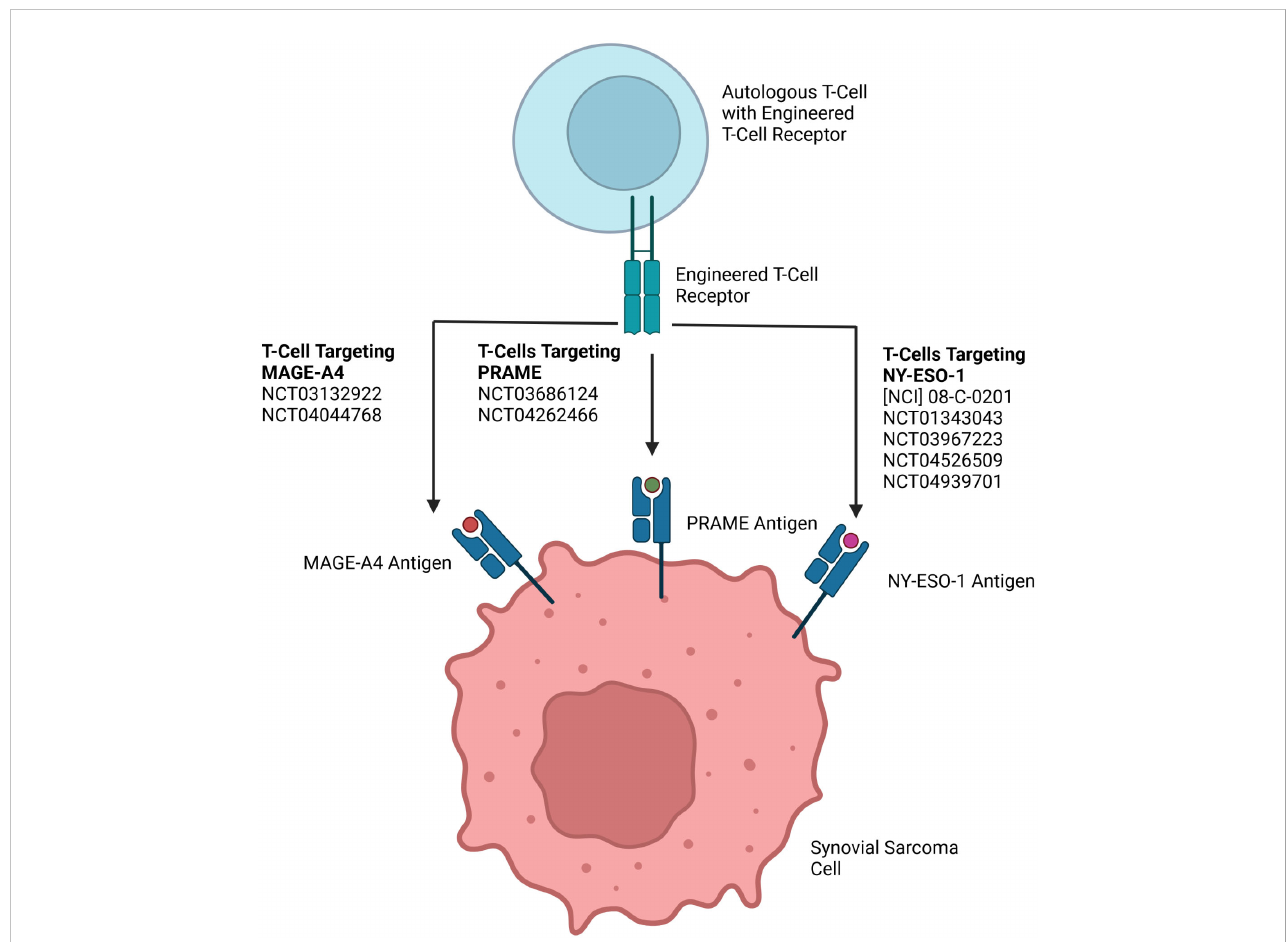
FIGURE 1 Adopted Cell Transfer engineered T-cell receptors targeting CTAs for treatment of